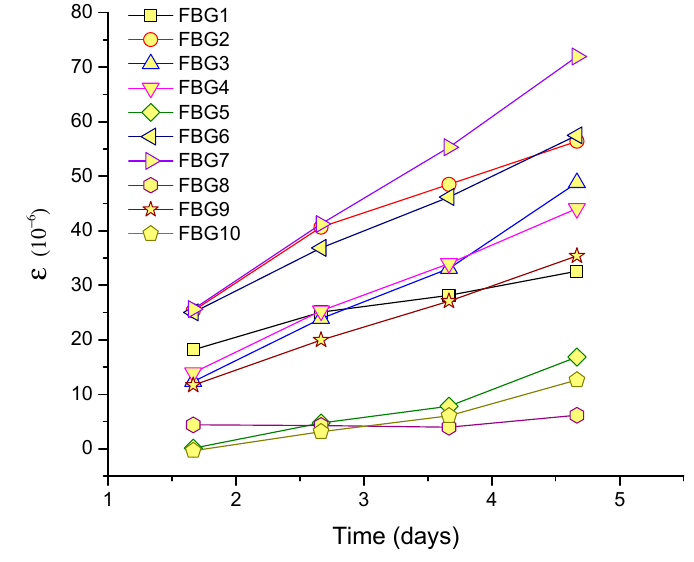
Figure 8. Time-history of pile strain after temperature compensation.